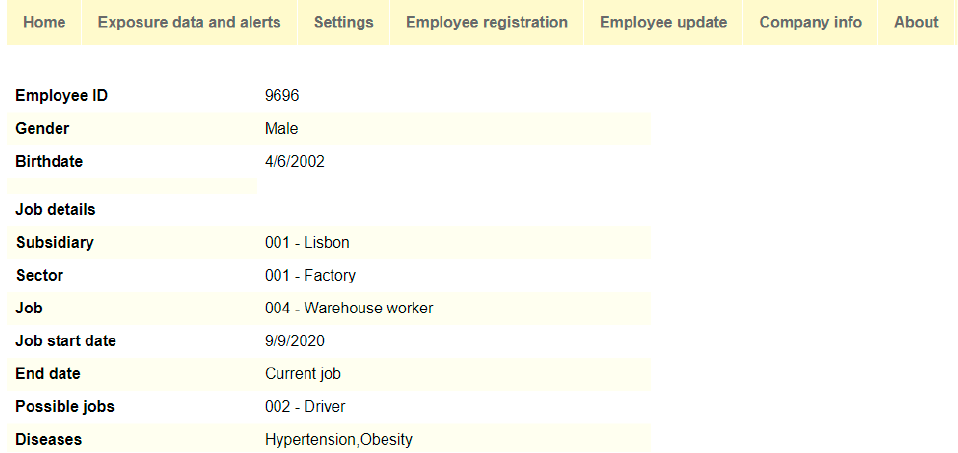
Figure 3. Example of registered jobs and risks.